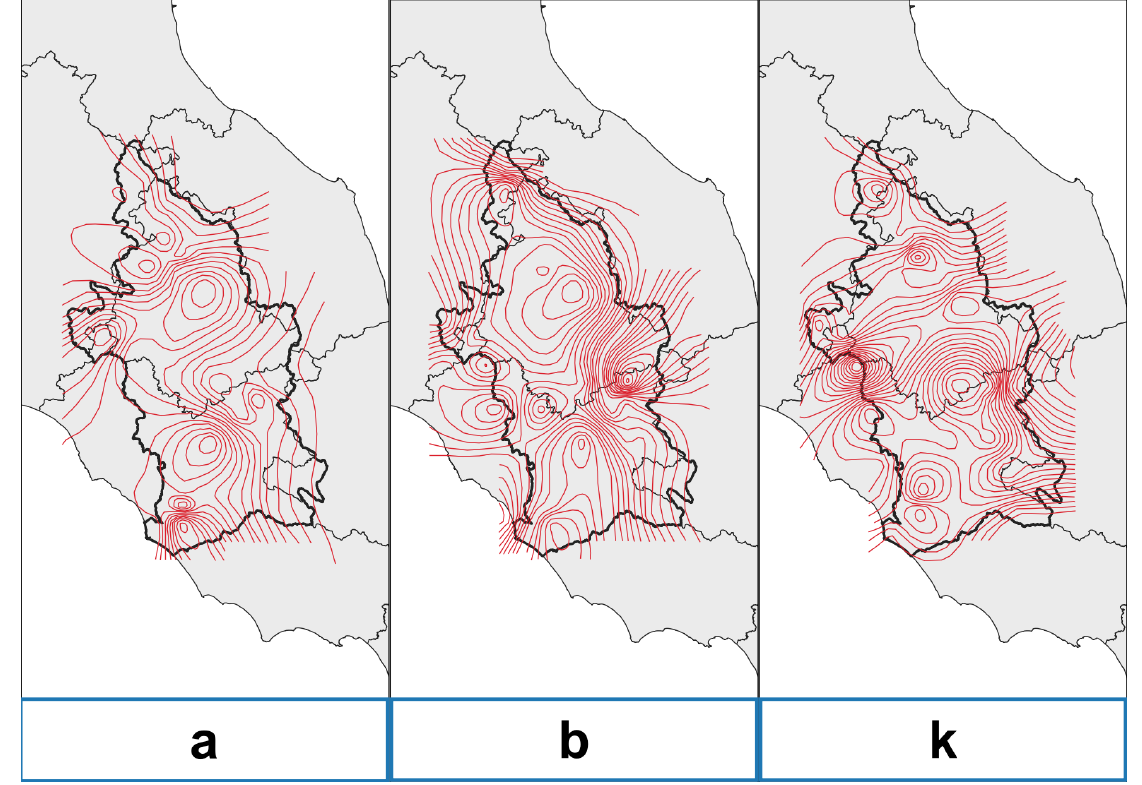
Figure 3. Values of Intensity-Duration-Frequency parameters a , b , and K expressed as isolines, provided by the Flood Estimation Handbook for the whole Tiber River